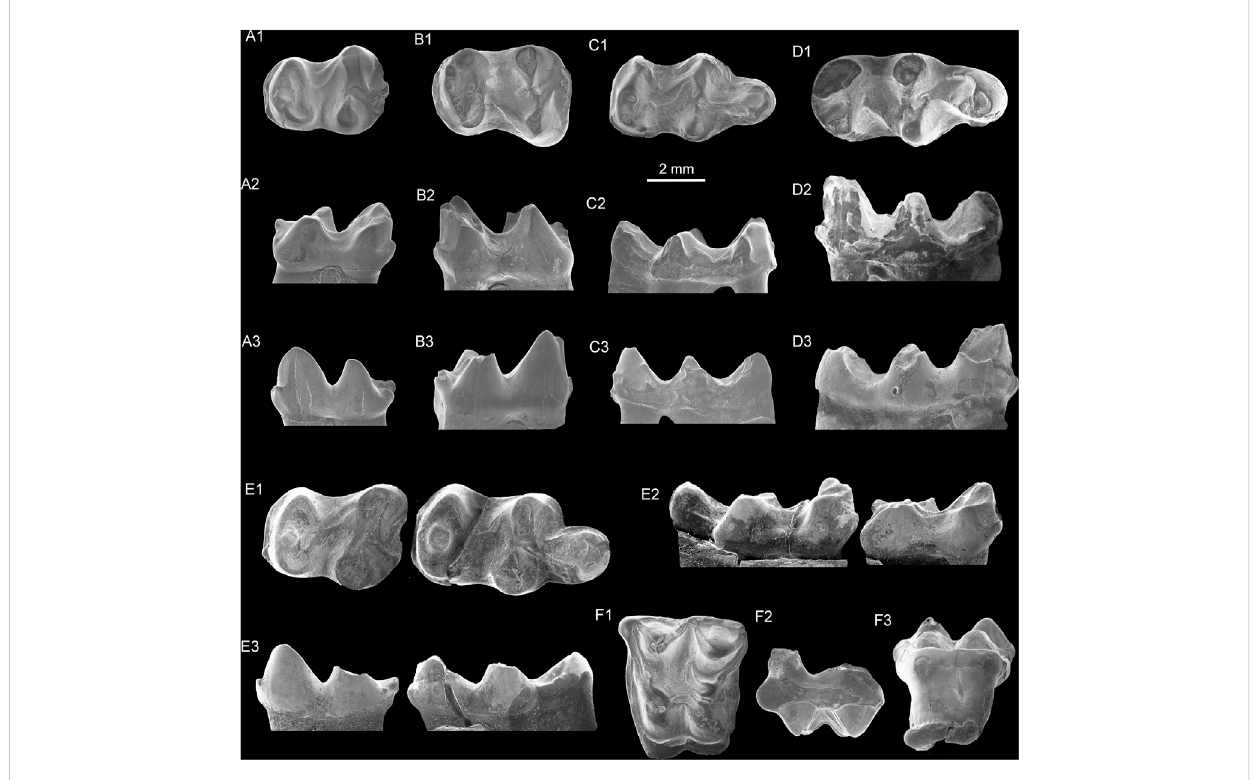
Lowermolarsof Obotheriumparvum gen.etsp.nov. (A – E) andtheuppermolarof? Obotheriumparvum (F) . (A) rightm1/2(holotype,IVPPV31726); (B) left m1/2 (V 31727.1); (C) right m3 (V 31727.2); (D) left m3 (V 31728.1); (E) right m2 – 3 (V 31729); (F) left M1/2 (IVPP V 31730): (A1 – F1) , occlusal